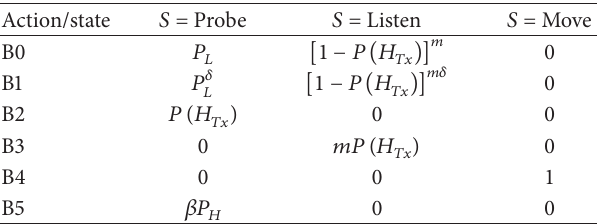
Table 1: Probability of